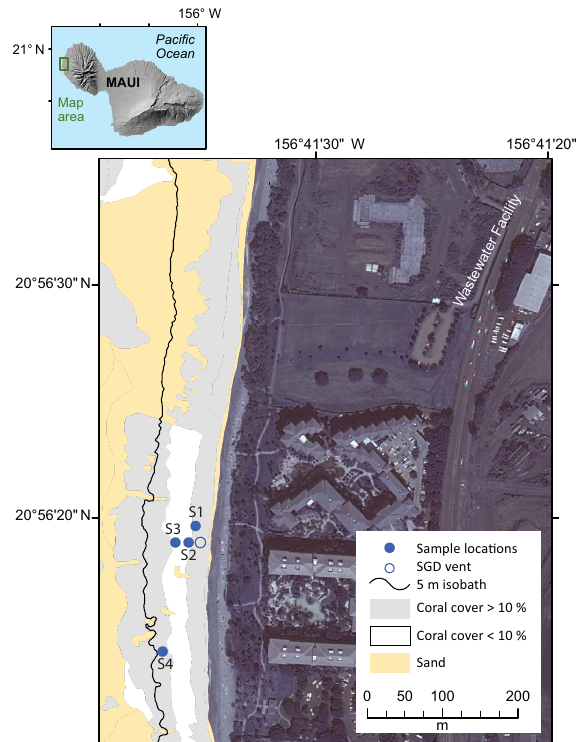
Figure 1. Location map of the island of Maui, Hawaii, USA, and the study area along West Maui. Bathymetric map (5m contours) of study area showing seawater sampling locations (blue closed circle) along Kahekili Beach Park, and the primary seep site (blue open circle) superimposed on distribution of percent coral cover versus